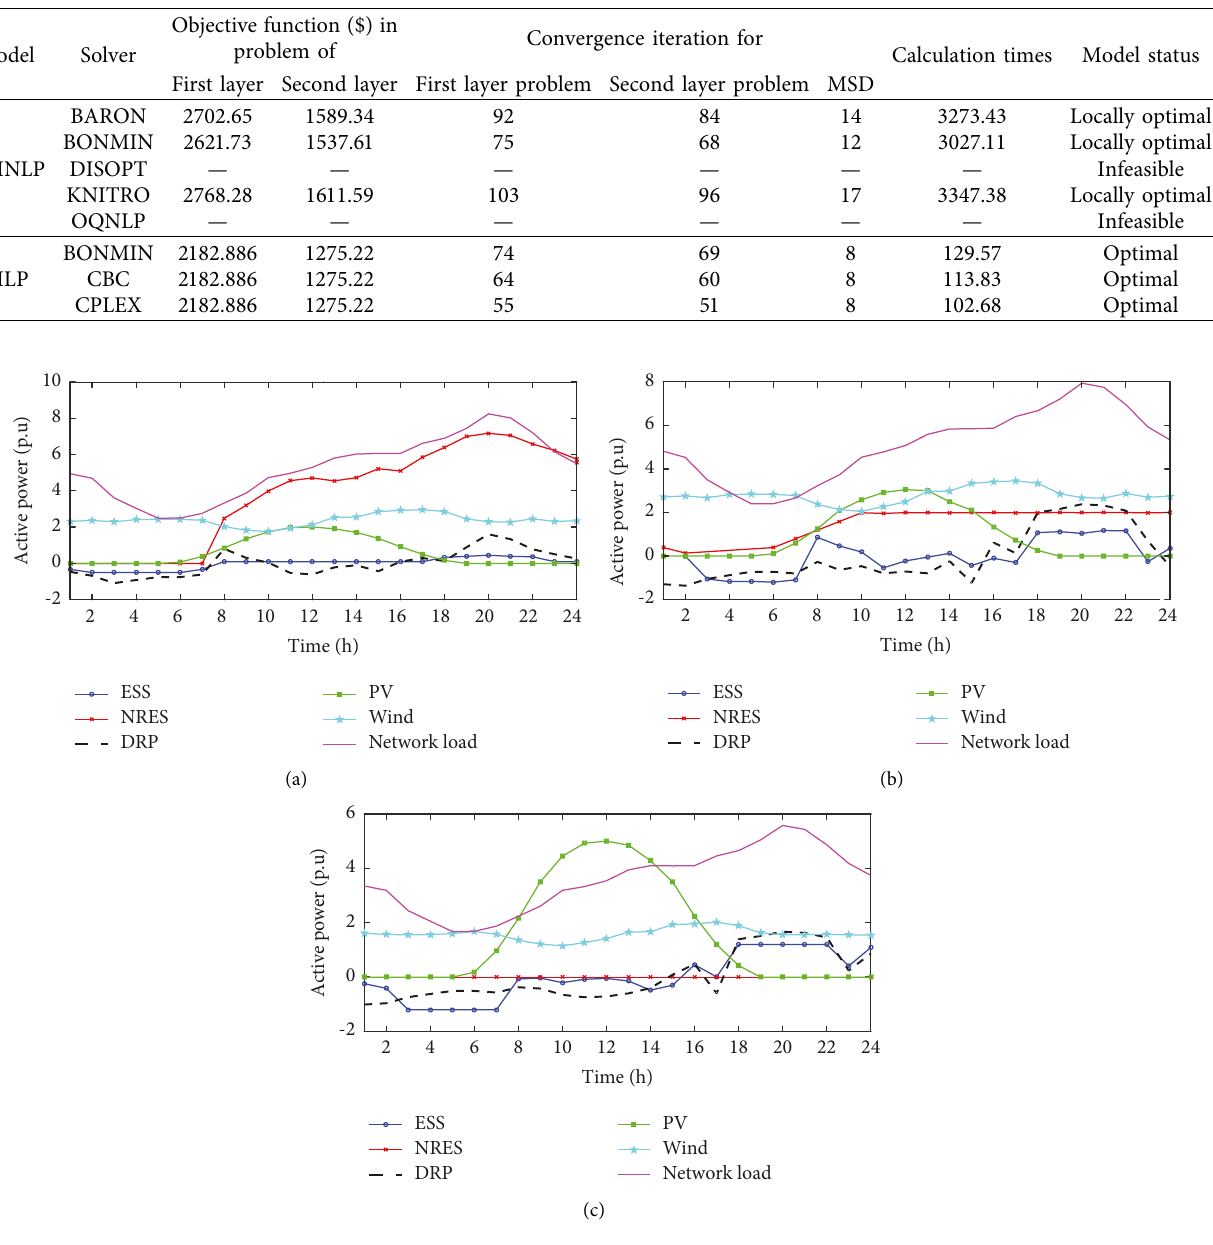
Figure 6: Daily expected total active power curve of different devices in (a) MG1, (b) MG2, and (c) MG3.